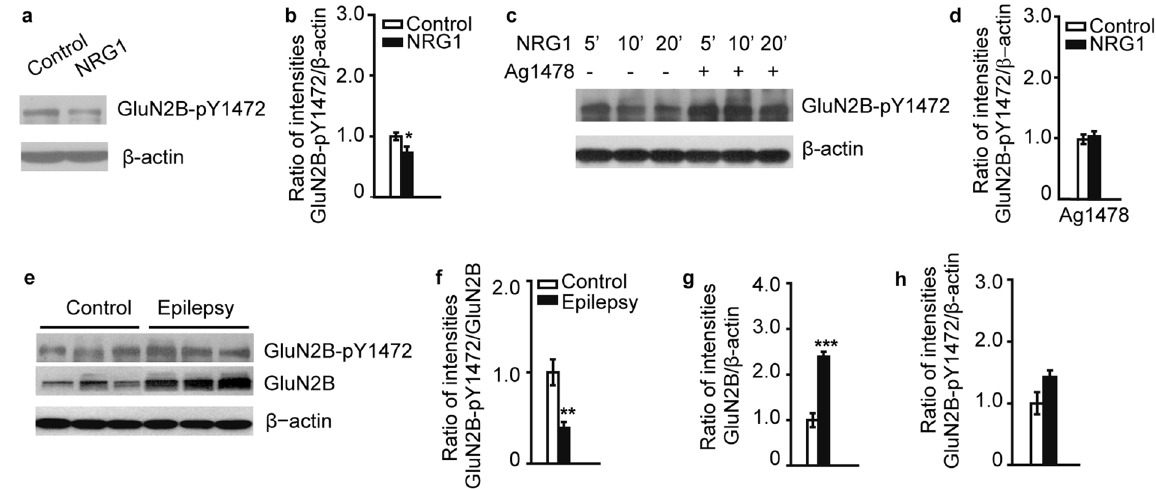
Figure 3. GluN2B as a downstream target of the NRG1-ErbB4 signaling in the human brain. ( a ) NRG1- treated brain slices exhibit a significant decrease in GluN2B-pY1472. ( b ) Quantification of GluN2B-pY1472 immunoblots (n = 8). ( c and d ) Pretreatment with the ErbB4 inhibitor Ag1478 prevented the decrease of GluN2B-pY1472 induced by NRG1 (n = 3). ( e ) Immunoblot of GluN2B-pY1472 in human symptomatic epileptic tissues. ( f ) The phosphorylation level of GluN2B at Y1472 was significantly decreased in the temporal cortex of patients with symptomatic epilepsy (n = 6 and 8). ( g ) GluN2B protein was significantly increased in symptomatic epilepsy tissues (n = 6 and 8). ( h ) The expression of GluN2B-pY1472 protein was not significantly different in symptomatic epilepsy tissues compared to control group (n = 6 and 8). * P < 0.05; ** P < 0.01; *** P < 0.001. Unpaired two-tailed Student’s t-test. Data are represented as the mean ±